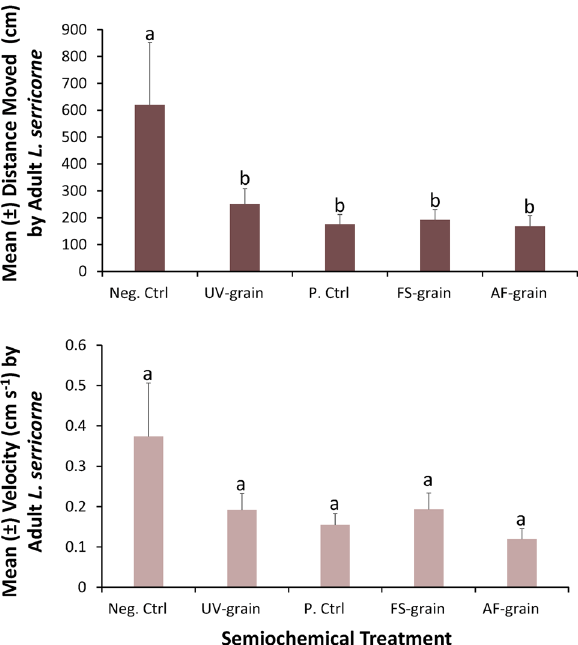
Figure 2. Metrics from the movement assay assessing the effects of MVOCs on mean distance moved (± SE, top panel) and the mean instantaneous velocity (± SE, bottom panel) by adult L. serricorne over a period of 30 min using a network camera coupled with Ethovision in the laboratory at the USDA-ARS Center for Grain and Animal Health Research in Manhattan, KS. There were a total of n = 20 replicates per treatment, translating to 50 h of data in this assay. Bars with shared letters are not significantly different from each other (Tukey HSD, α = 0.05). Neg. Ctrl, negative control; UV-grain, UV-sanitized grain; P. Ctrl, uninoculated grain; FS-grain, F. verticillioides -inoculated grain; AF-grain, A. flavus -inoculated